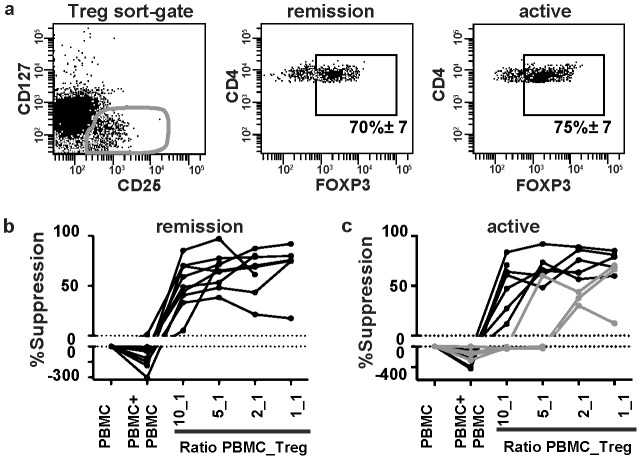
Tregs from patients with active JDM exhibit a compromised suppressive function.(A) Representative dot plots of FOXP3 expression of gated CD4+CD25+CD127low T cells (left dot plot) of JDM patients in remission (middle dot plot), or with active disease (right dot plot), showing means ± S.E.M. (B, C) CD4+CD25+CD127low T cells were sorted into co-cultures with anti-CD3 activated autologous PBMC in different ratios. Proliferation was measured on day 6 by 3H thymidine incorporation. Level of suppression of PBMC proliferation was calculated by comparison to proliferation of PBMC cultured alone (suppression = 0%). (B) Suppression by CD4+CD25+CD127low T cells from 9 patients in remission and (C) 11 patients with active disease, grey lines represent 4 patients displaying defective suppression in one or more conditions with Tregs present. Defective suppression is defined as an increased proliferation in the presence of the sorted Tregs, in at least one of the co-culture ratios.